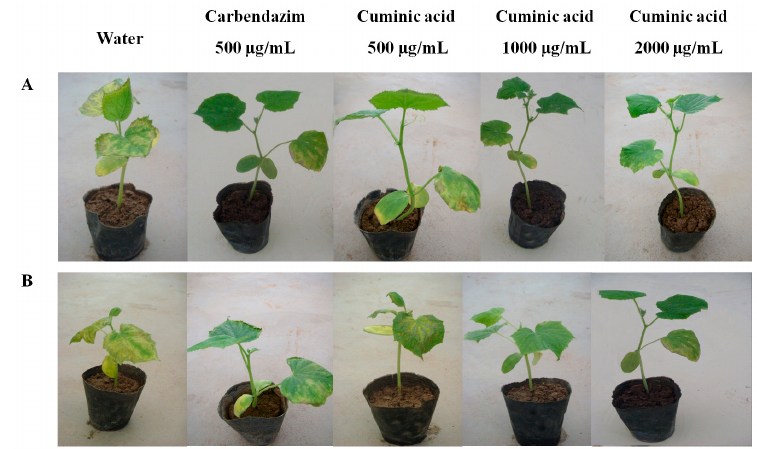
Figure 2. ( A ) Protective and ( B ) curative activity of cuminic acid against C. lagenarium .